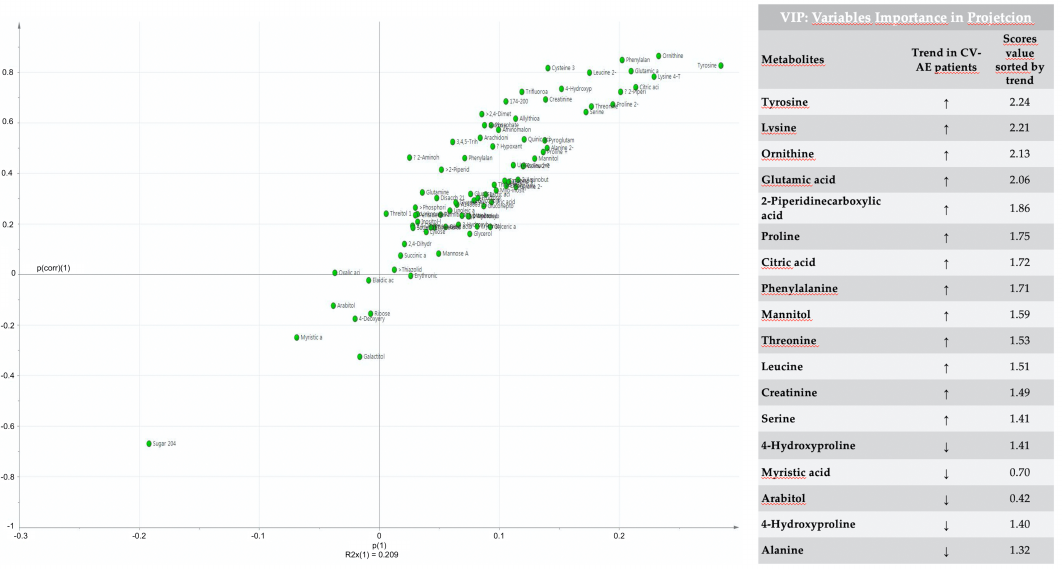
Figure 2. The loadings plot combines the modeled covariance and correlation from the multivariate model (OPLS-DA), the p (1)-axis describe the variable magnitude of each variable, while the p(corr) (1)-axis represents the reliability of each variable. The most important biomarkers, variables importance in projections (VIP), have high magnitude and high reliability and are circled in the figure and listed as metabolites accumulated or depleted in CV-AE patients sorted by